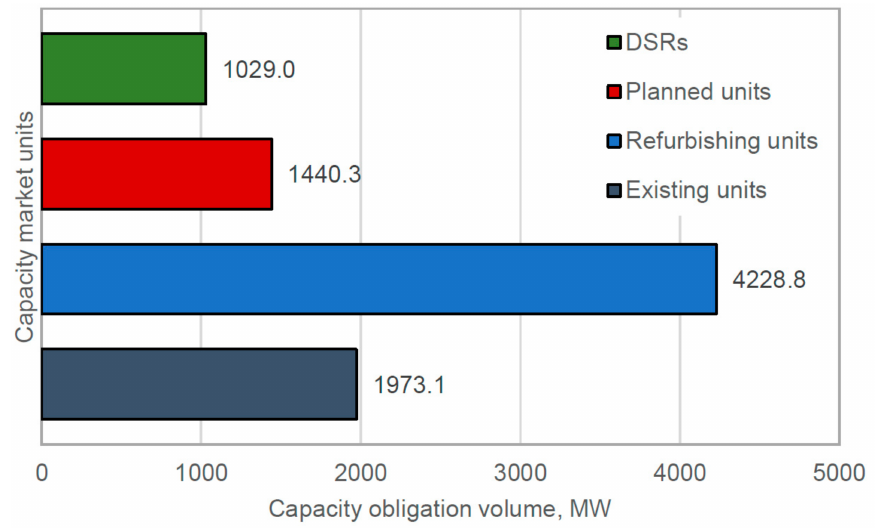
Figure 10. Capacity obligation volume contracted in main capacity auction for 2024 delivery year– break down by official (declared) assignments to capacity market units. Source: Own analysis based on [40].